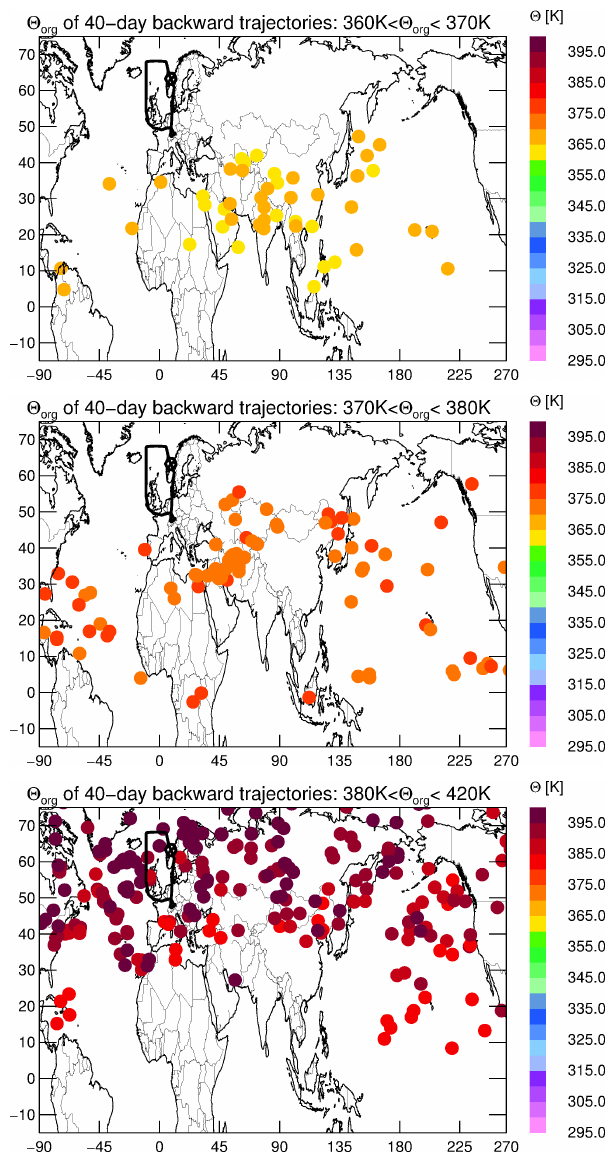
Figure 4. The geographical position of the origins ( (cid:50) org ) of the Fig. 4. The geographical position of the origins ( Θ org ) of the 40- 40-day backward trajectories for intervals 360–370K (top), 370– day backward trajectories for intervals 360–370K (top), 370–380K 380K (middle) and 380–420K (bottom) are shown colour-coded (middle) and 380–420K (bottom) are shown colour-coded by po- by potential temperature. The corresponding trajectories are shown tential temperature. The corresponding trajectories are shown in the in the electronic supplement of this electronic supplement of this paper.